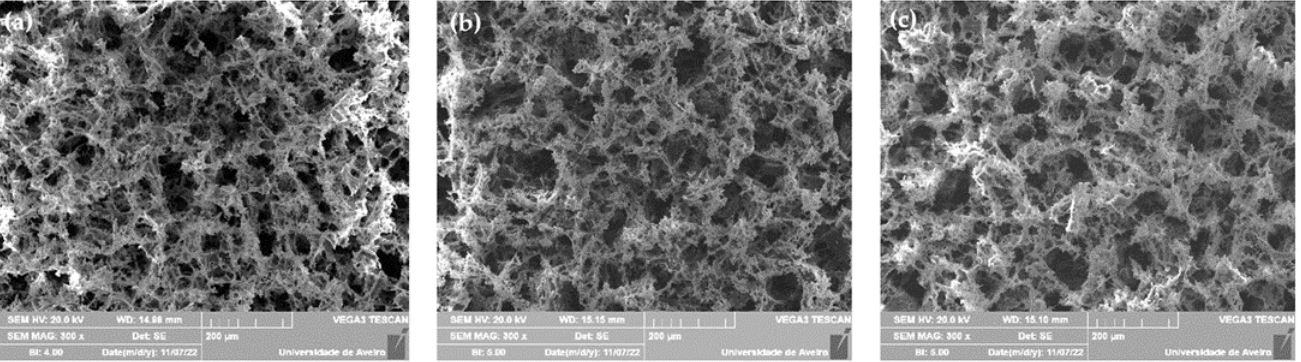
Figure 9. SEM micrographs (magnification: 300×) of the membranes ( a ) PCL, ( b ) PCL:BG and ( c ) PCL:BGZn2.